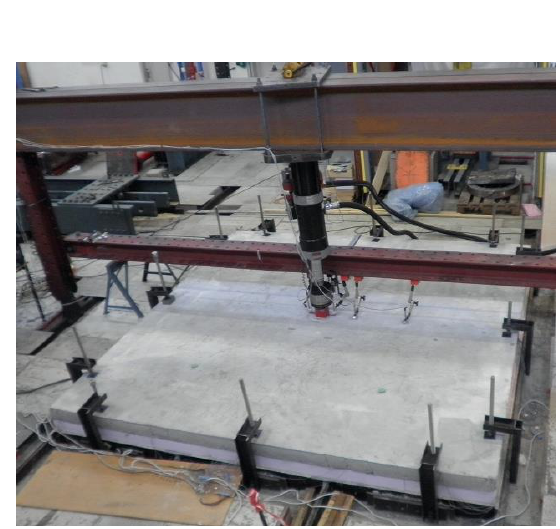
Figure 3. Ground slab and test set-up